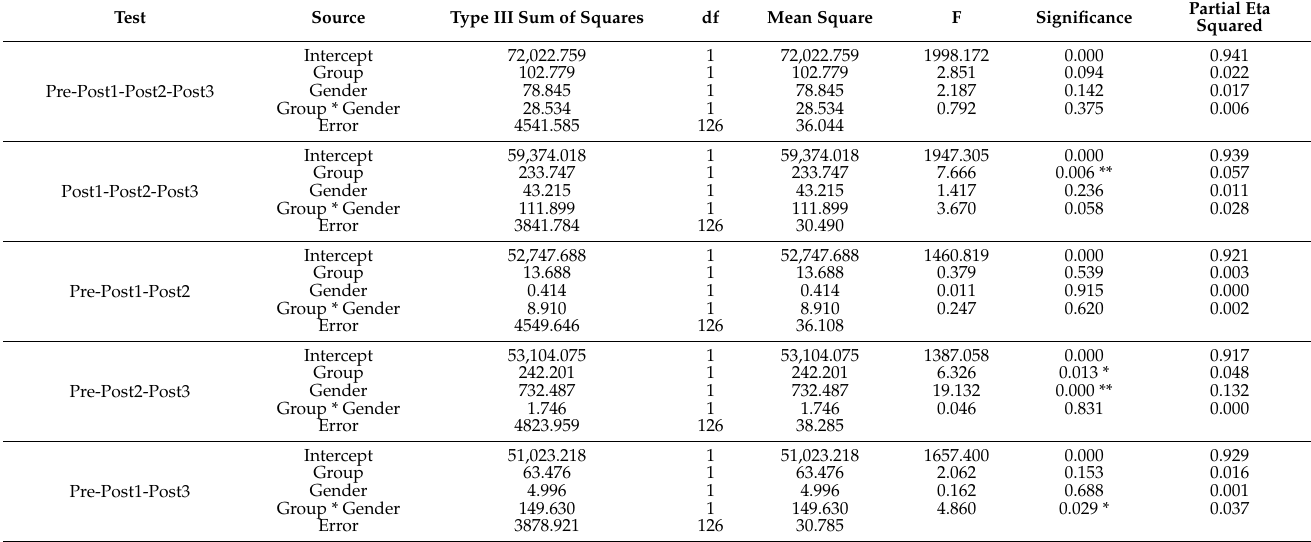
Table 6. Results of Inter-Subject Effects from Repeated-Measures ANOVA.